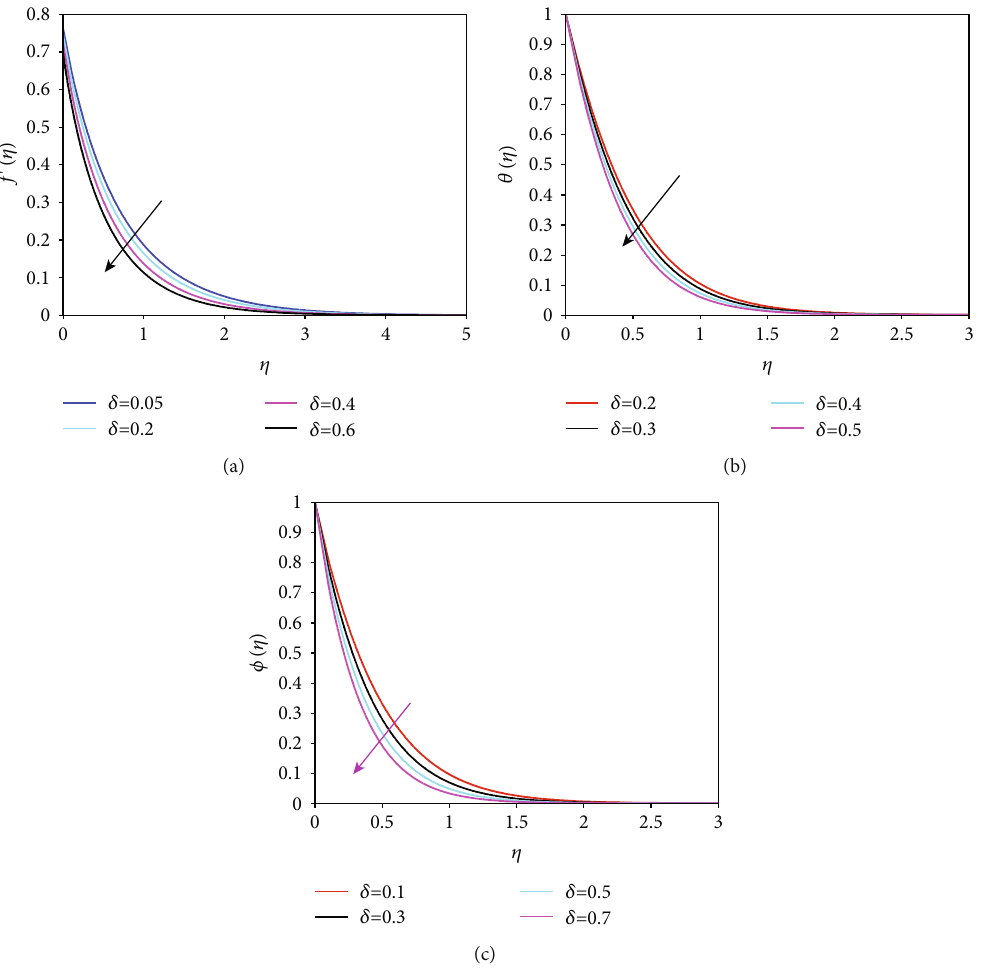
Figure 2: The graph of velocity, temperature, and concentration for di ff erent values of suction ( δ